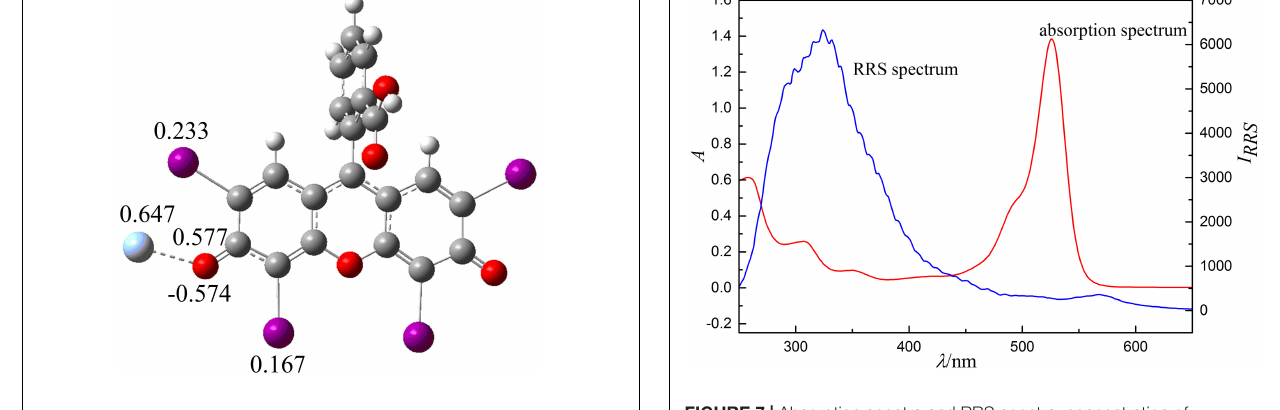
Frontiers in Nutrition |